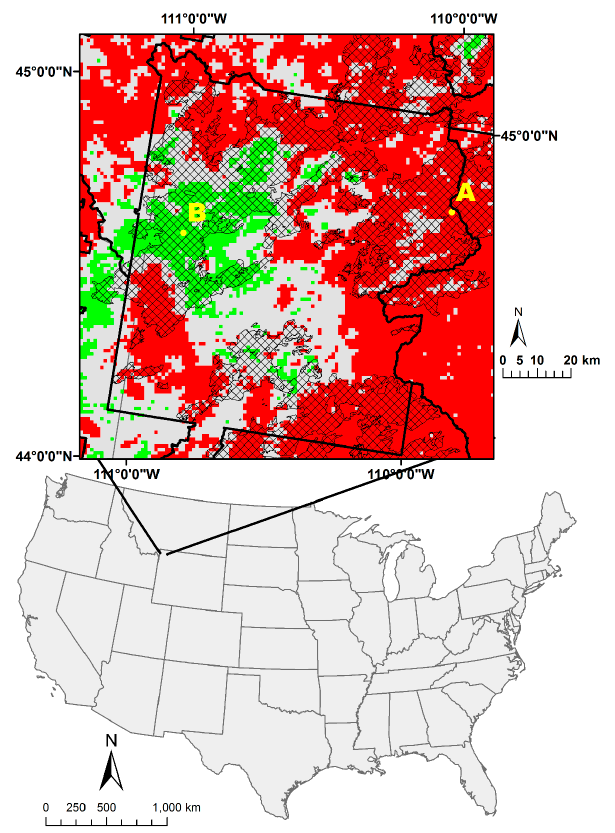
Figure 6. The 1988 Yellowstone fire polygon (black hatching) within Yellowstone National Park (dark black lines). Green and red pixels indicate significant increase and decrease in the NDVI over time (multivariate autoregression), respectively. Labeled symbols A and B are the locations of the pixels used in Figures S2 and S3, respectively, showing NDVI behavior over time. (Fire polygon from